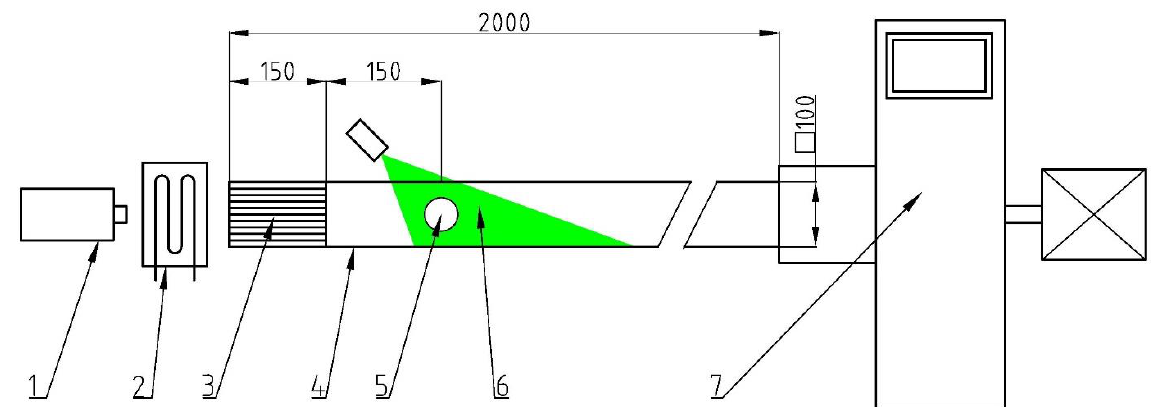
Fig. 1. Experimental apparatus. 1 fog generator, 2 heater, 3 honeycomb, 4 experimental channel, 5 experimental area, 6 laser sheet, 7 radial fan and electric